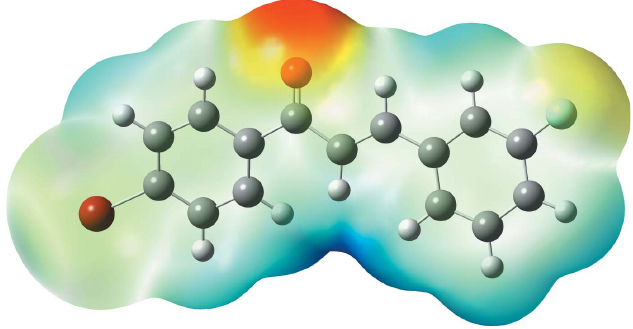
Figure 8 The molecular electrostatic potential surface of the title compound